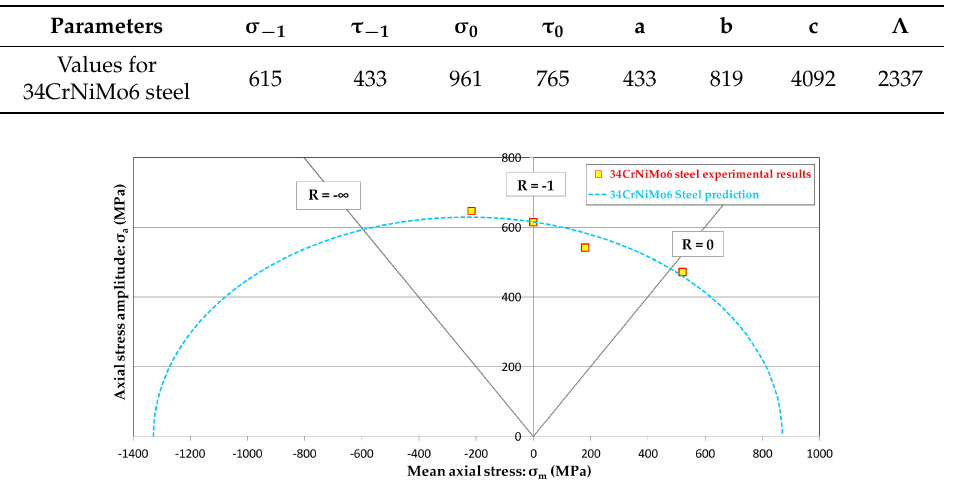
Figure 12. Haigh diagram with the experimental results for several structural steels and their predictions from the proposed method, Equation (17). Table 7. Relative errors (%) of the proposed physical theory for N = 2 × 10 6 cycles. Positive values mean conservative results predicted by the theory, negative values non-conservative